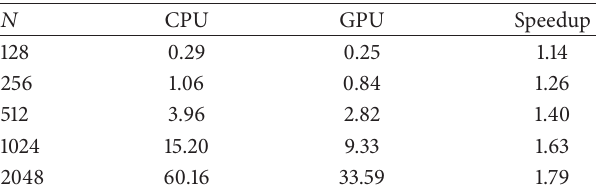
Table 3: Performance comparison between optimized GPU solu- tion on Quadro FX 5800 and parallel CPU solution on E5540 with fixed 𝑀 = 122880